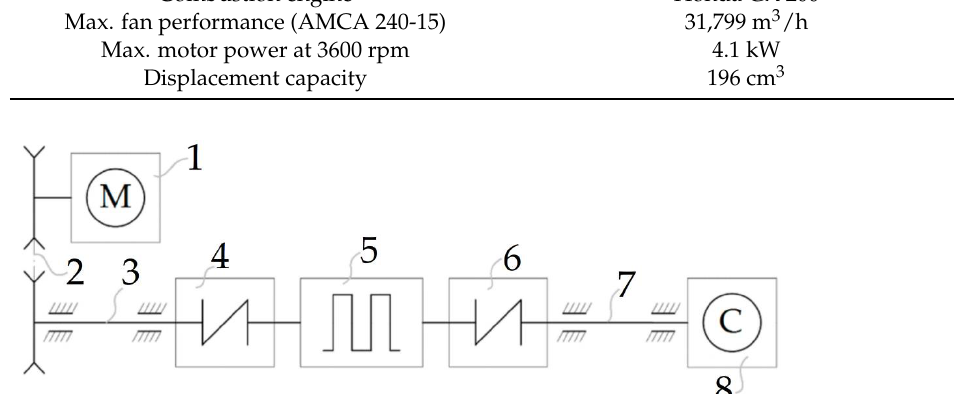
Figure 1. Mobile positive pressure fans used in rescue operations: ( a ) conventional fan, ( b ) turbo fan (W2), and ( c ) turbo fan impeller.